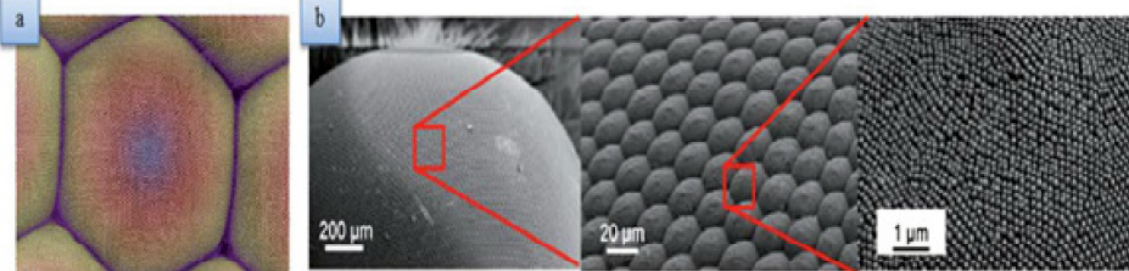
Fig. 6. (a) Image from SEM depicting little bumps on the eye of a moth, (b) SEM images that are magnified drill down illustrating the hexagonal arrangement of sub-wavelength nanostructures. Reprinted with permis-